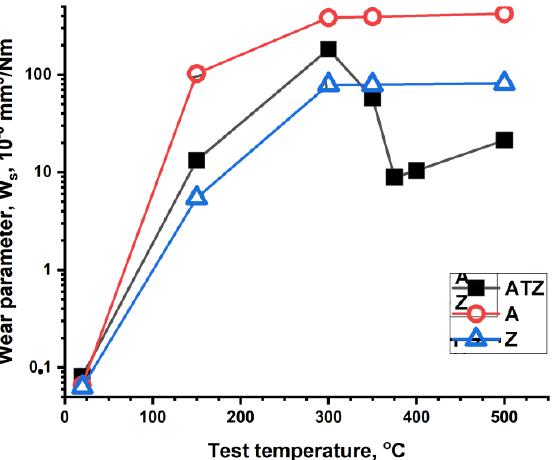
Figure 8. Plots of the counterpart (ball) wear parameter W b values measured at different tempera- tures of the test. The symbols present the mean value of the three single measurements.